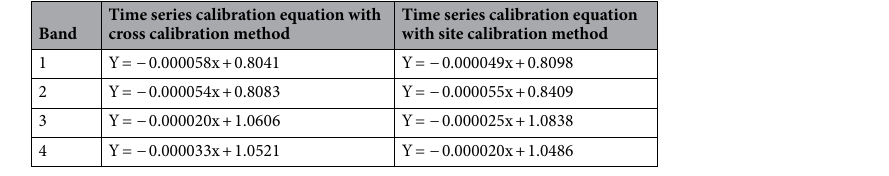
Table 3. Comparison of time series calibration coefficients of HJ-1A CCD1. Coefficients Unit: W/(m 2 sr µm).